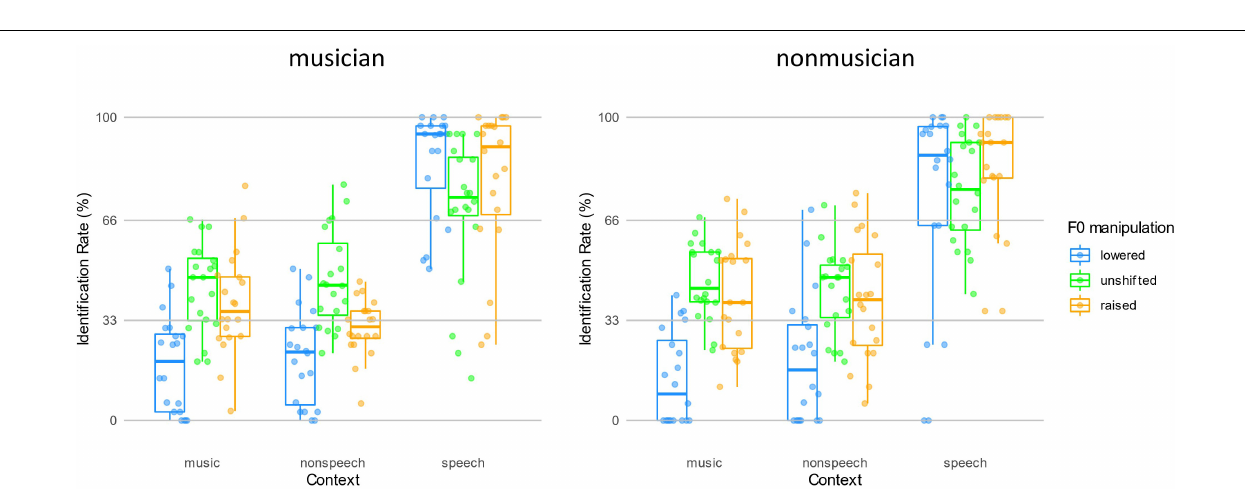
FIGURE 4 | The identification rate of the target following three contexts with F0 manipulations in two